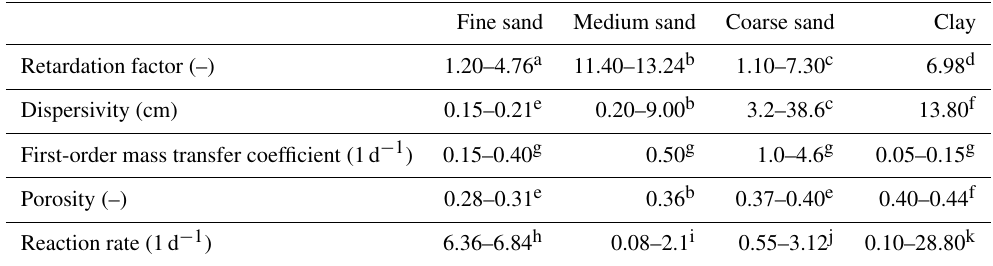
Table 4. A partial list of parameters from the literature.